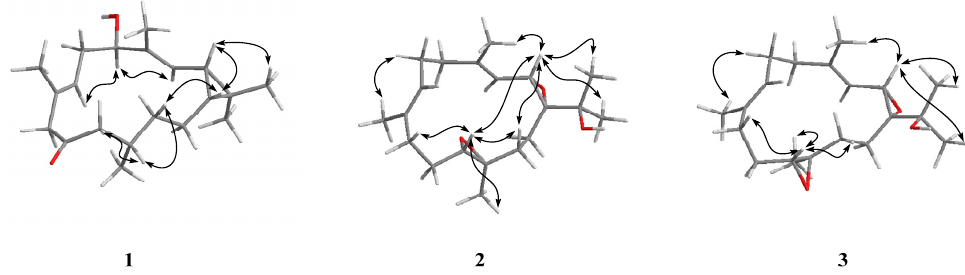
Figure 3. Computer ‐ generated model of 1 – 3 using MM2 force calculations and key NOE correlations. The HRNSIMS ( m / z 321.2418 [M + H] + , calcd. for C 20 H 33 O 3 , 321.2424) of 2 suggested the molecular